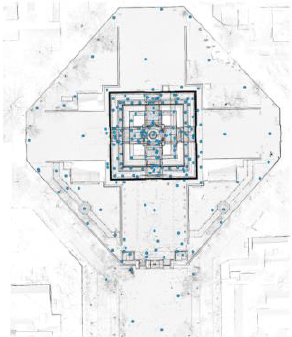
Figure 2. Three-dimensional scanning